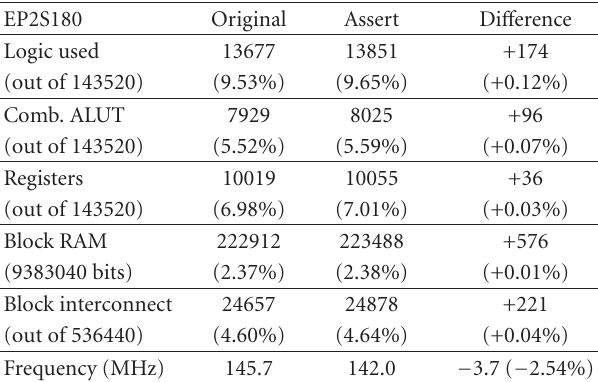
Table 1: Triple-DES assertion